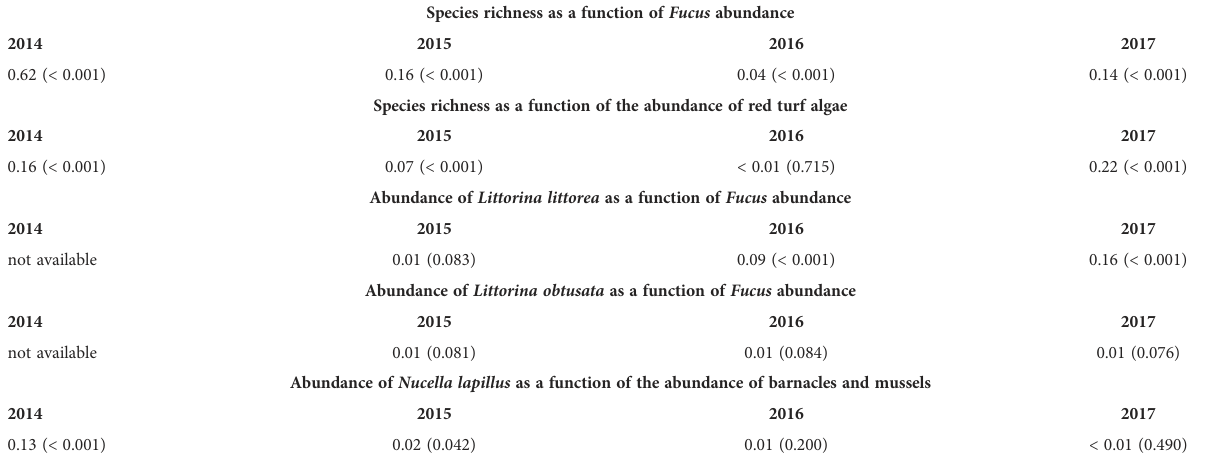
TABLE 6 Summary results for correlation analyses ( R 2 , with P in parenthesis) examining species associations. Refer to Materials and Methods for details. Species richness as a function of Fucus